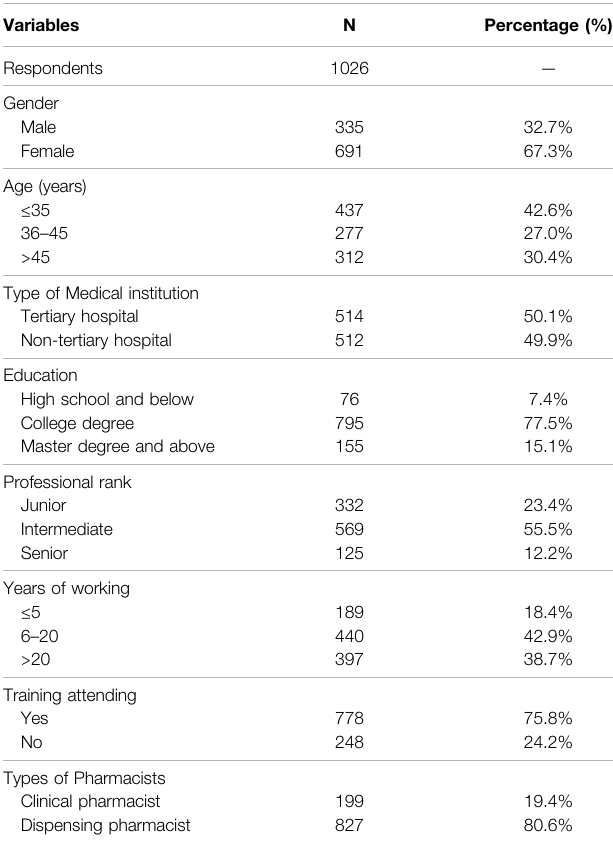
TABLE 1 | Characteristics of pharmacists.